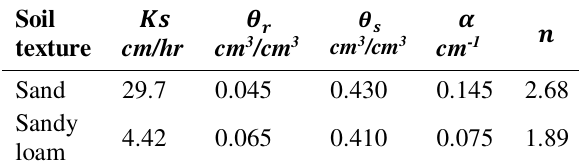
Soil texture and related hydraulic properties.